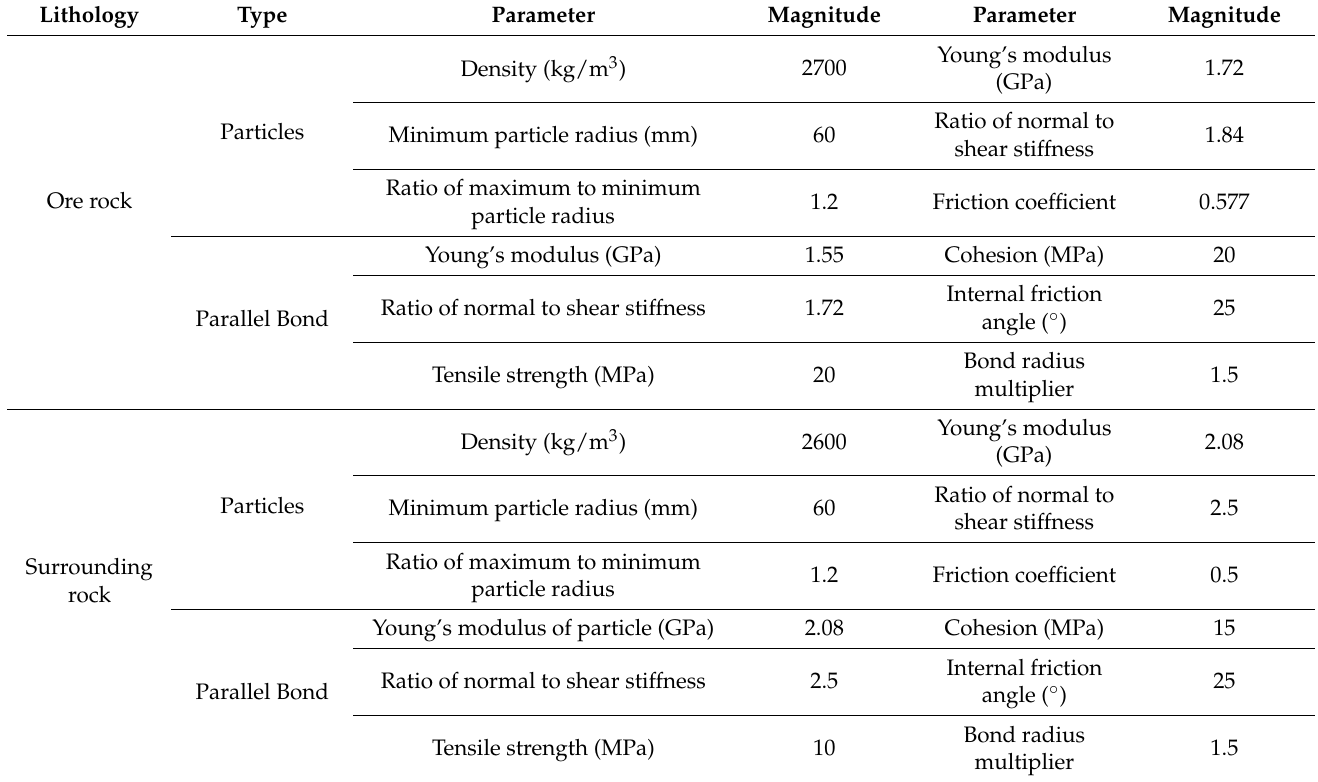
Table 4. Microscopic parameters in PFC.